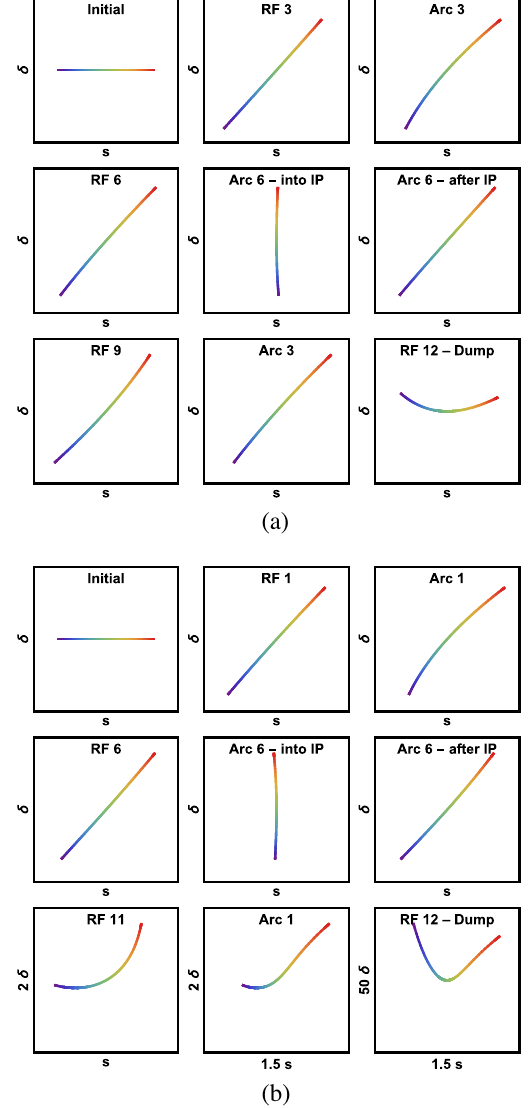
FIG. 11. Sequences of compressive common transport longi- tudinal matches with different choice of linearizing arcs. Longi- tudinal phase spaces at the exit of the specified elements. The remaining arcs have a nonzero T 566 of their natural sign. (a) uses arc 3 to linearize, (b) uses arc 1 to linearize. Note the change of scale in the later stages of